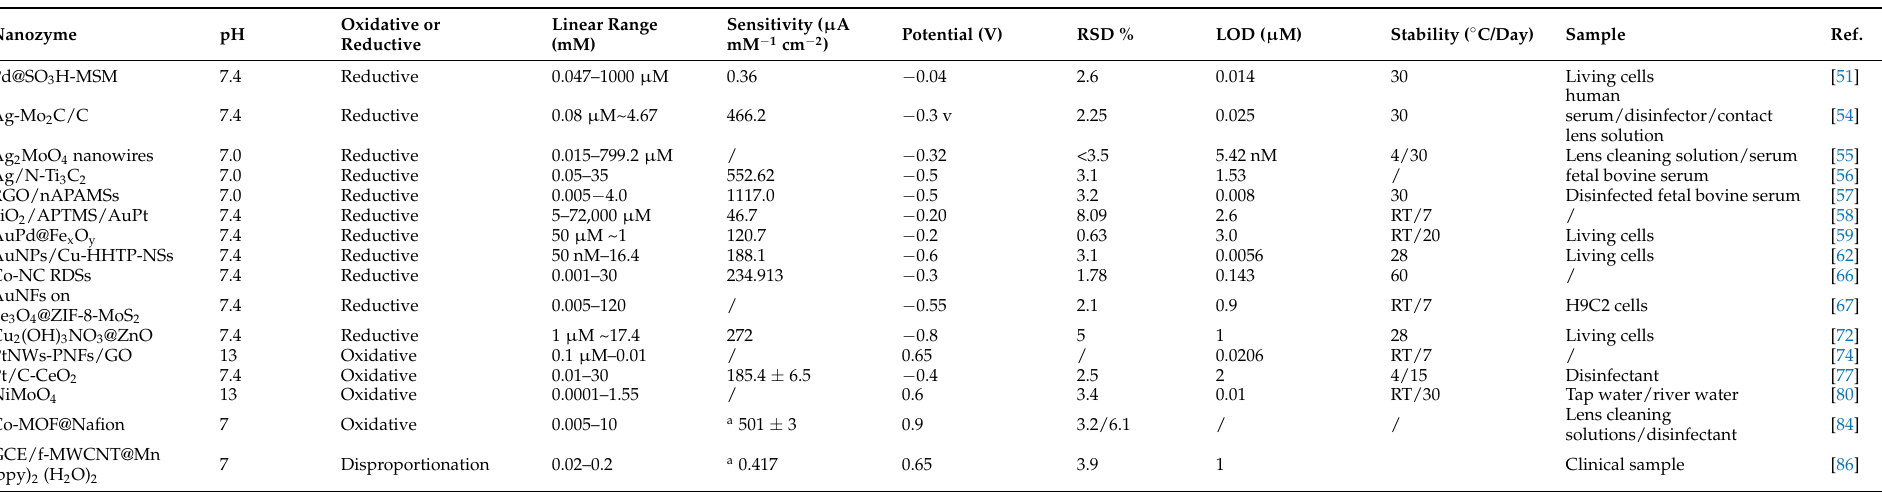
Table 2. Summary of amperometric sensors using nanozymes for the detection of H 2 O 2 (LOD: limit of detection; RSD: relative standard deviation; a : data have been normalized by us; /: not reported; Ref.: